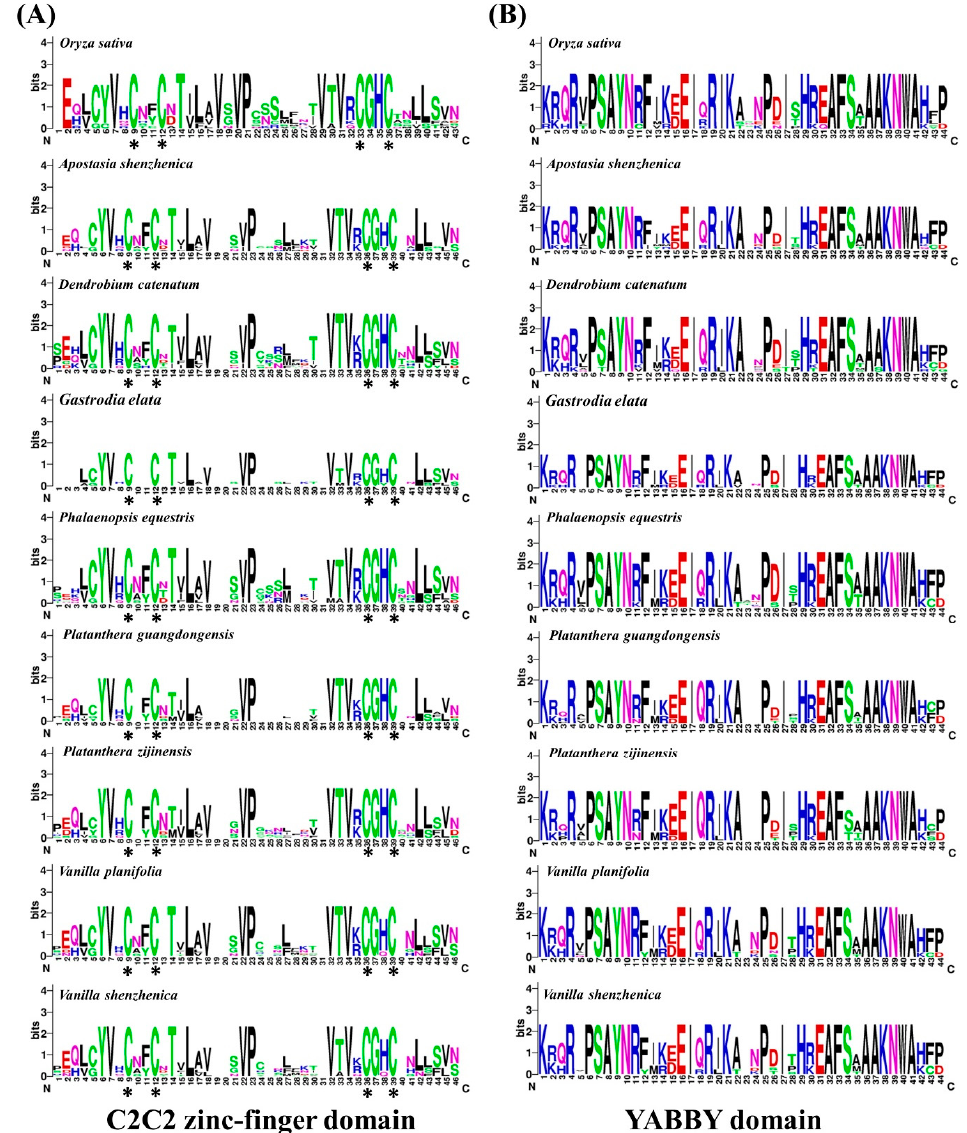
Figure 2. Conserved domains of orchid and rice YABBY protein sequences. ( A ) Sequence logo revealing the N-terminal conserved zinc-finger domain. Conserved cysteine residues in the zinc-finger domain are indicated with black asterisks. ( B ) Sequence logo showing the C-terminal conserved YABBY domain.